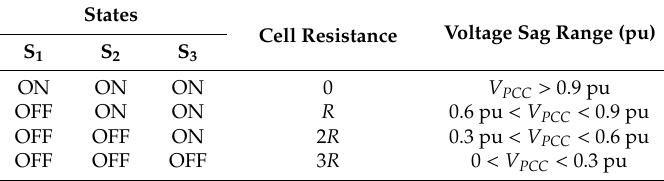
Table 3. Switching states of MCFCL for three cell.